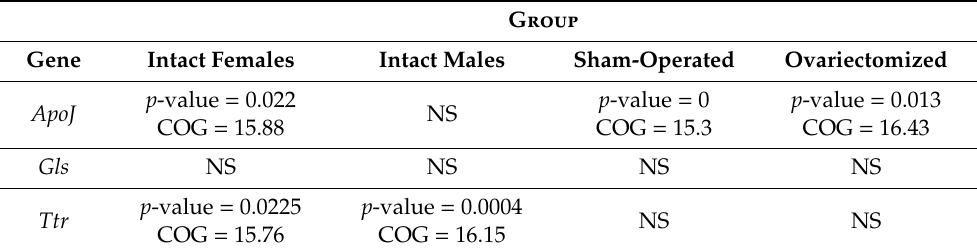
Table 1. Significance ( p -value) and center of gravity values for each A β scavenger’s gene as determined by CircWave analysis.